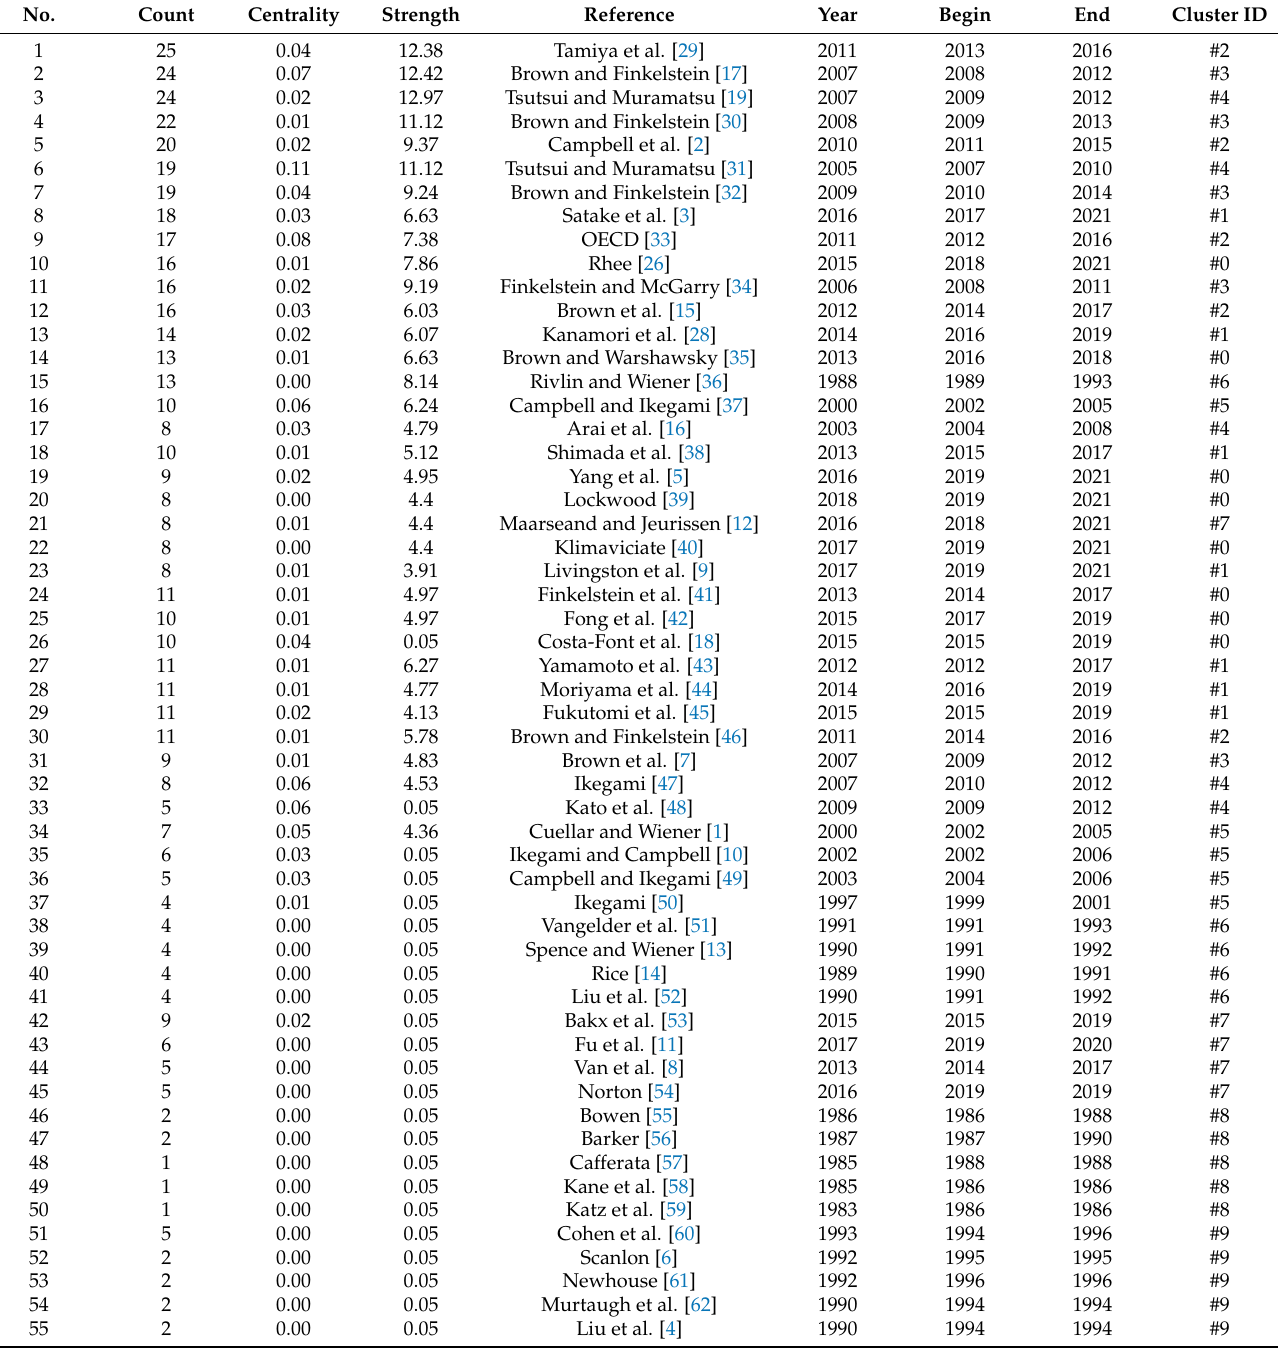
Table 4. List of 55 representative references based on citations, centrality, and